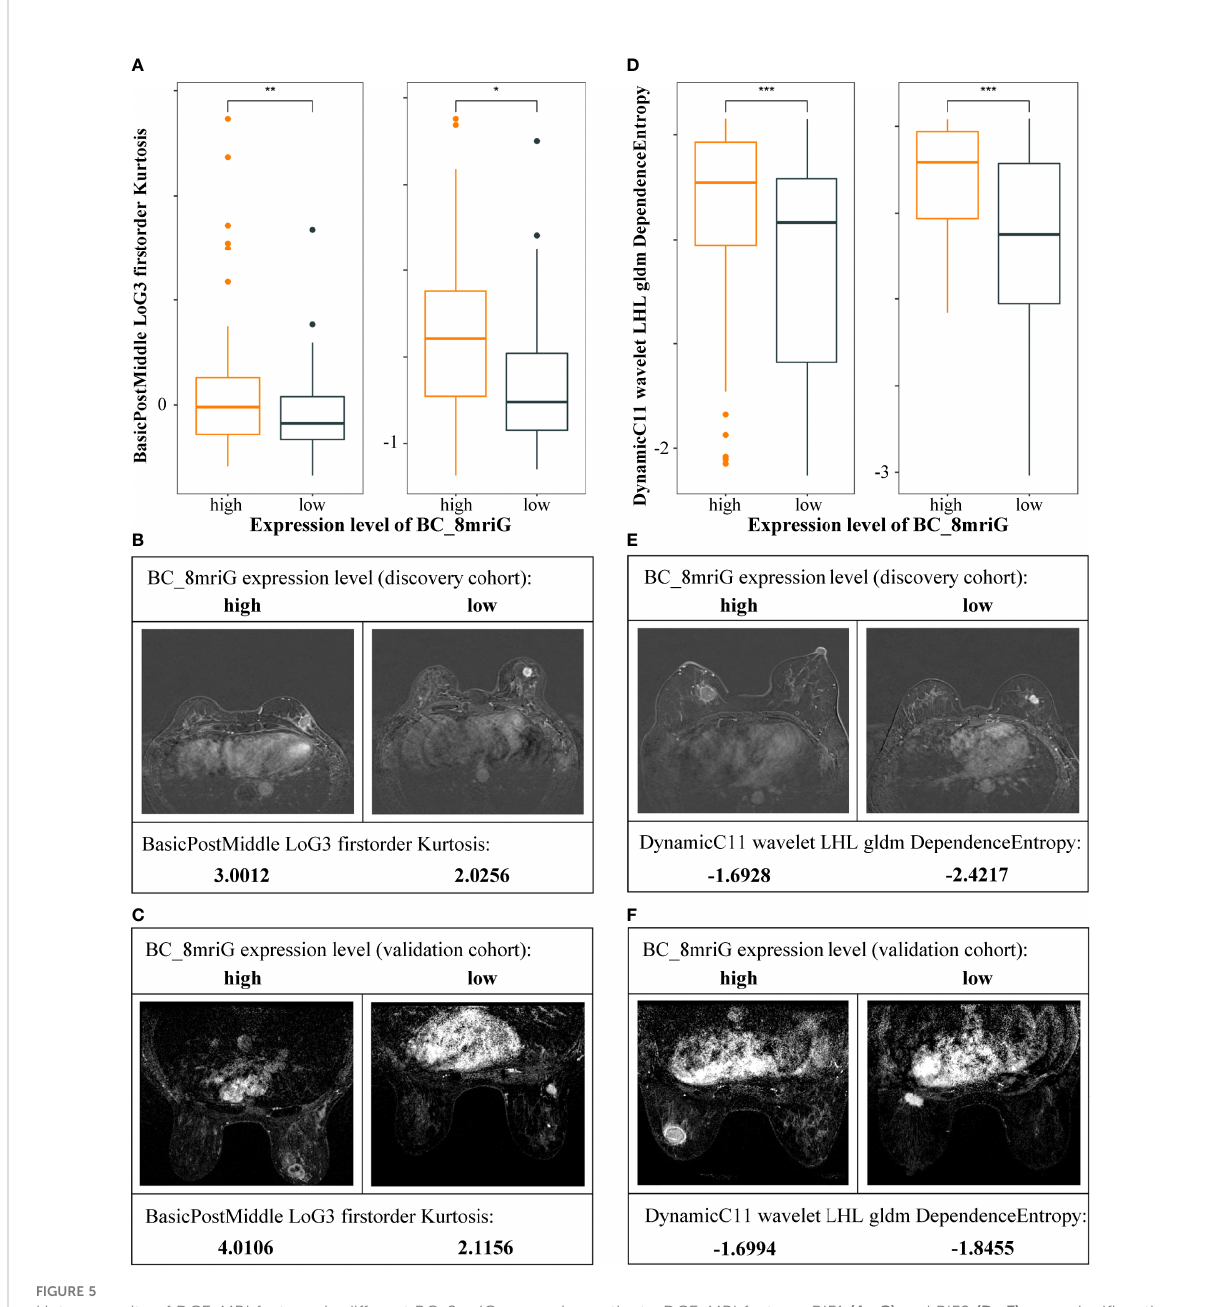
FIGURE 5 Heterogeneity of DCE-MRI features in different BC-8mriG expression patients. DCE-MRI features BIF1 (A – C) and BIF2 (D – F) were signi fi cantly different in samples with high and low expression of BC-8mriG in both discovery and validation cohorts (*, **, and ***: p -values < 0.05, 0.01, and 0.001, respectively). DCE, dynamic contrast